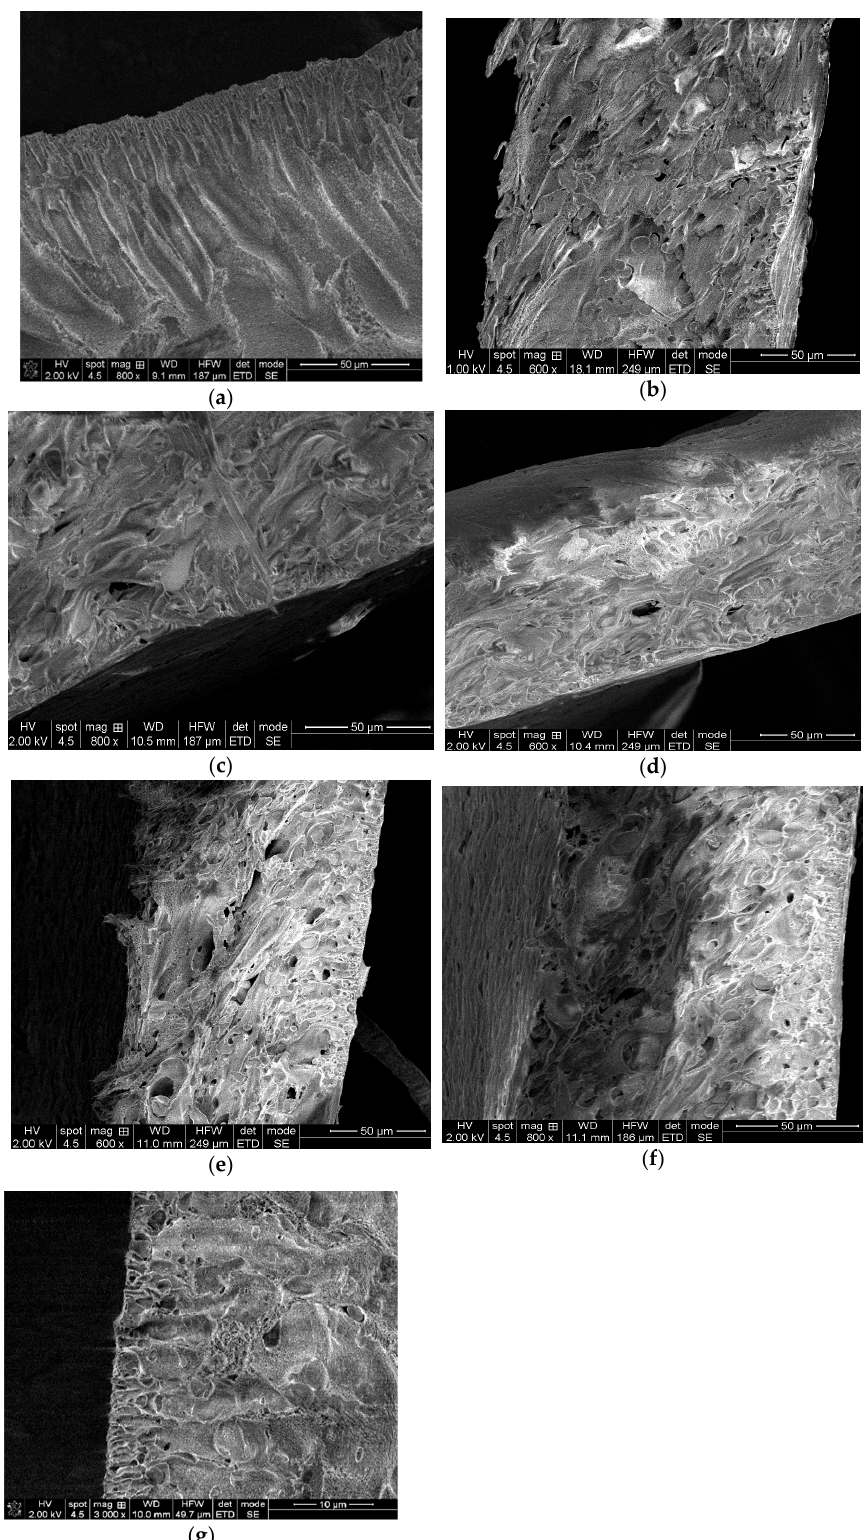
Figure 1. SEM cross-sectional images for the obtained membranes, where: ( a ) M0 control membrane; ( b ) M1 membrane; ( c ) M1-L2-M1 membrane exposed to laser for 2 min; ( d ) M1-L5-M1 membrane exposed to laser for 5 min; ( e ) M1-L10-M1 membrane exposed to laser for 10 min; ( f ) M2-L5-M2 membrane exposed to laser for 5 min; and ( g ) M3-L5-M3 membrane exposed to laser for 5